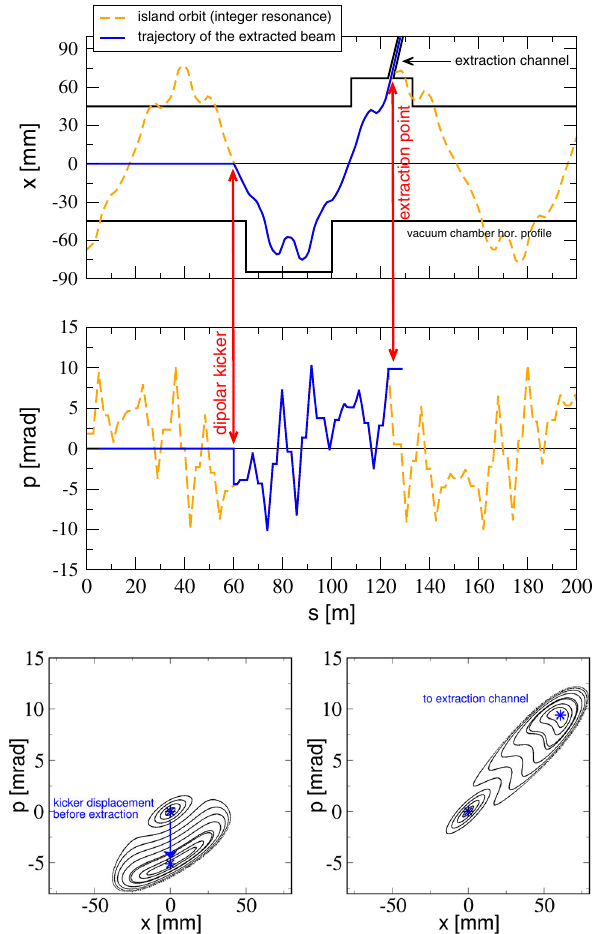
FIG. 7. Example of STE obtained by moving the beam from the central orbit to one inside a stable island of the integer resonance. The island orbit and the trajectory during extraction are displayed in the upper plots (orange and blue curves, respectively), whereas the phase space portraits in the bottom plots refer to the location of the dipolar kicker (left) and of the extraction point (right). The large deflection angle of about 5 mrad can be reduced by appropriate insertion optics around the kicker as shown in Fig.